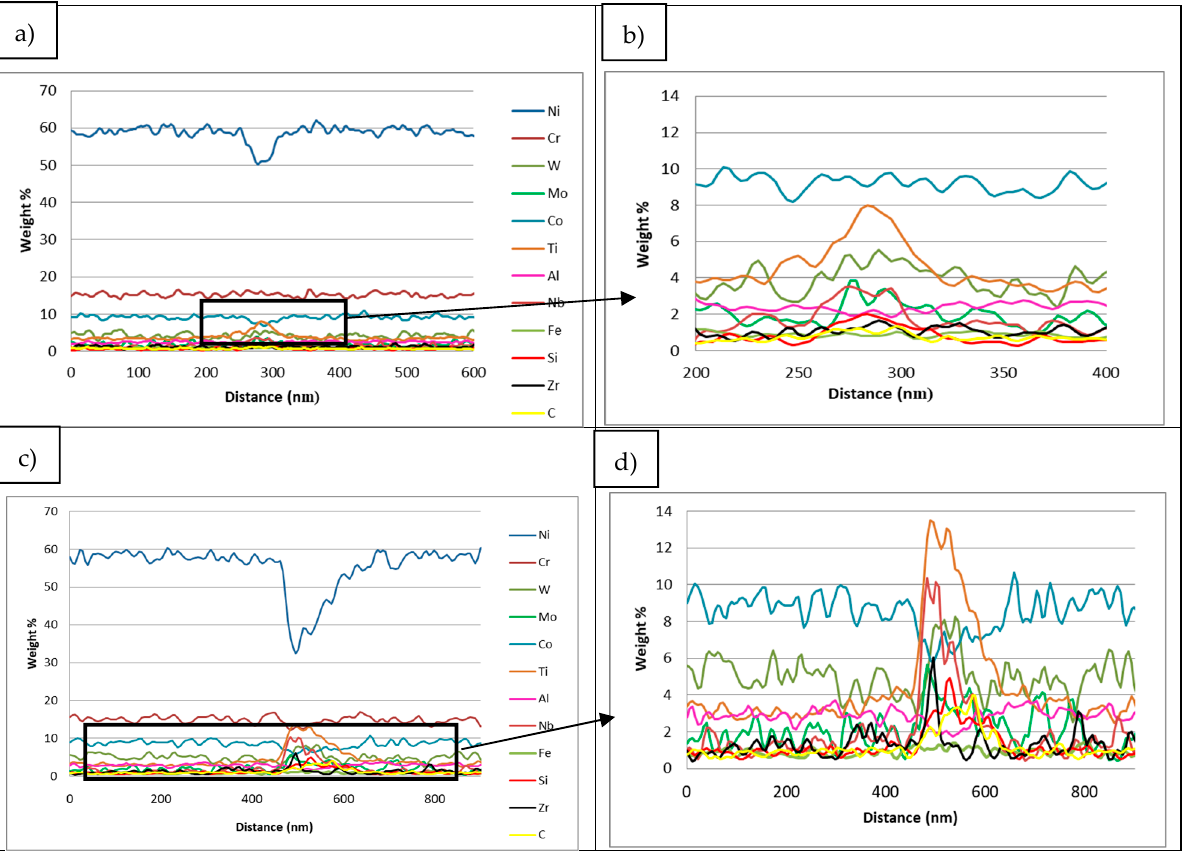
Figure 12. ( a ) LPW sample cell boundary line-scan, ( b ) zoom of LPW sample cell boundary line-scan and ( c ) A&D sample grain boundary line-scan and ( d ) zoom of A&D sample grain boundary line-scan.